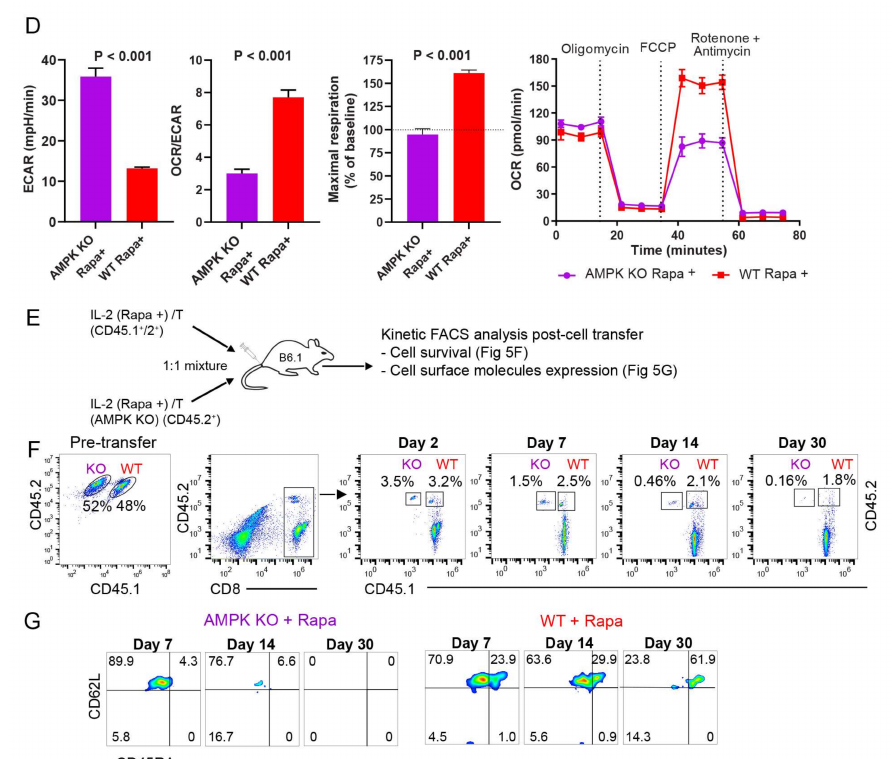
Figure 5. AMPK α 1 deficiency abolishes metabolic AMPK α 1 pathway, reduces mitochondrial bio- genesis and induces a metabolic switch from FAO to glycolysis in AMPK α 1 KO IL-2(Rapa+)/T-cells. ( A ) Schematic diagram indicates splenic CD8 + T-cell culture for generating rapamycin-treated T-cells from wild-type (WT) and AMPK α 1 KO. OVA-specific naïve CD8 + T-cells from the WT OT-1 mice or from AMPK α 1 KO mice were activated by 0.1 nM OVAI-peptide in IL-2 containing media for 3 days. Following the wash, activated T-cells were treated with rapamycin (100 nM) in IL-2 containing media for 2 additional days to form IL-2(Rapa+)/T M and AMPK KO IL-2(Rapa+)/T M cells. ( B ) Cell lysates from IL-2(Rapa+)/T M and AMPK KO IL-2(Rapa+)/T M cells were examined by the Western blot analysis. ( C ) Confocal microscopy shows mitochondrial mass as indicated by MitoTracker green staining in IL-2(Rapa+)/T M and AMPK KO IL-2(Rapa+)/T M cells. MitoTracker green stained mitochondria (white arrow) and Hoechst stained nucleus (blue). ( D ) Bar diagrams show basal extracellular acidification rates (ECAR, left bar diagram panel), basal ECAR/OCR ratio (middle bar diagram panel), and maximal oxygen consumption rates (right bar diagram panel; horizontal dotted line indicates a basal OCR, and OCR values above this line is a mitochondrial spare respiratory capacity (SRC) in respective groups; Line diagram shows OCR measured in real-time under basal conditions and in response to indicated mitochondrial inhibitors (red—WT; purple—AMPK α 1 KO); p < 0.0001 after FCCP injection. ( E ) The schematic diagram indicates rapamycin-treated T-cells generated from congenic OT-1 mice using WT mice from CD45.1 + /2 + background and AMPK α 1 KO from CD45.2 + background. Rapamycin treated wild type (CD45.1 + /2 + ) or rapamycin-treated AMPK α 1 KO (CD45.2 + ) effector T-cells were mixed 1:1 and adoptively transferred into CD45.1 mice. ( F ) The cell survival kinetics of adoptively transferred WT (CD45.1 + /2 + ) or AMPK α 1 KO (CD45.2 + ) effector T-cells in total host CD8 + T-cells were analyzed longitudinally in peripheral blood by flow cytometry. Flow panels show the relative percentage of rapamycin-treated WT (CD45.1 + /2 + ) or AMPK α 1 KO (CD45.2 + ) effector T-cells post-adoptive transfer ( n = 4). ( G ) Flow panels indicate cell phenotype of rapamycin-treated WT (CD45.1 + /2 + ) or rapamycin-treated AMPK α 1 KO (CD45.2 + ) T-cells at indicated days post-adoptive transfer ( n = 4). Data shown are from two to three independent experiments and are presented as means ± SEM ( n = 4/group). * p < 0.05, ** p < 0.01, *** p < 0.001 by two-tailed Student’s t